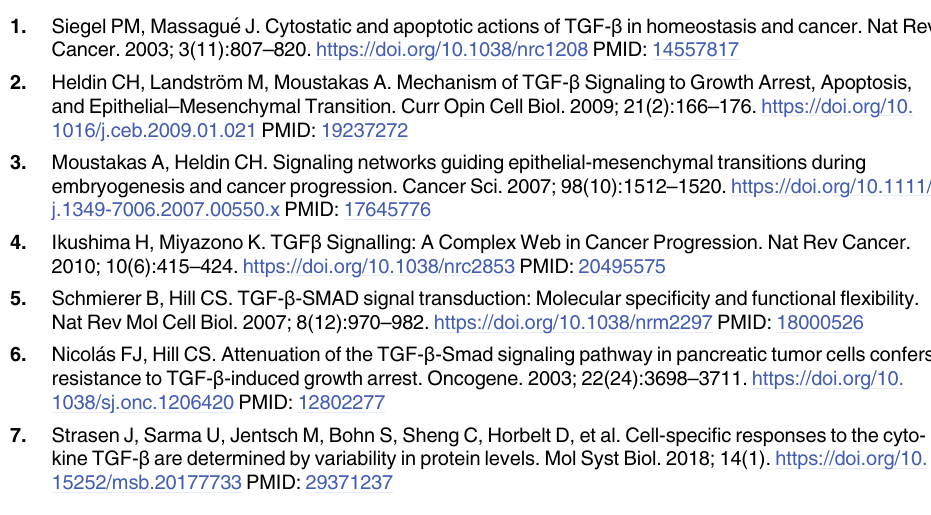
S8 Table. Comparison to alternative vesicle model. Distance measurements of the vesicle model (see S7 Fig) in comparison to the CIR model and the deterministic model relative to experimental data for stimulation with 100 pM TGF- β (compare Table 1). While the number of bursts predicted by the vesicle model matches the experimental data, the fit in standard deviation and population average is increased compared to the CIR model.